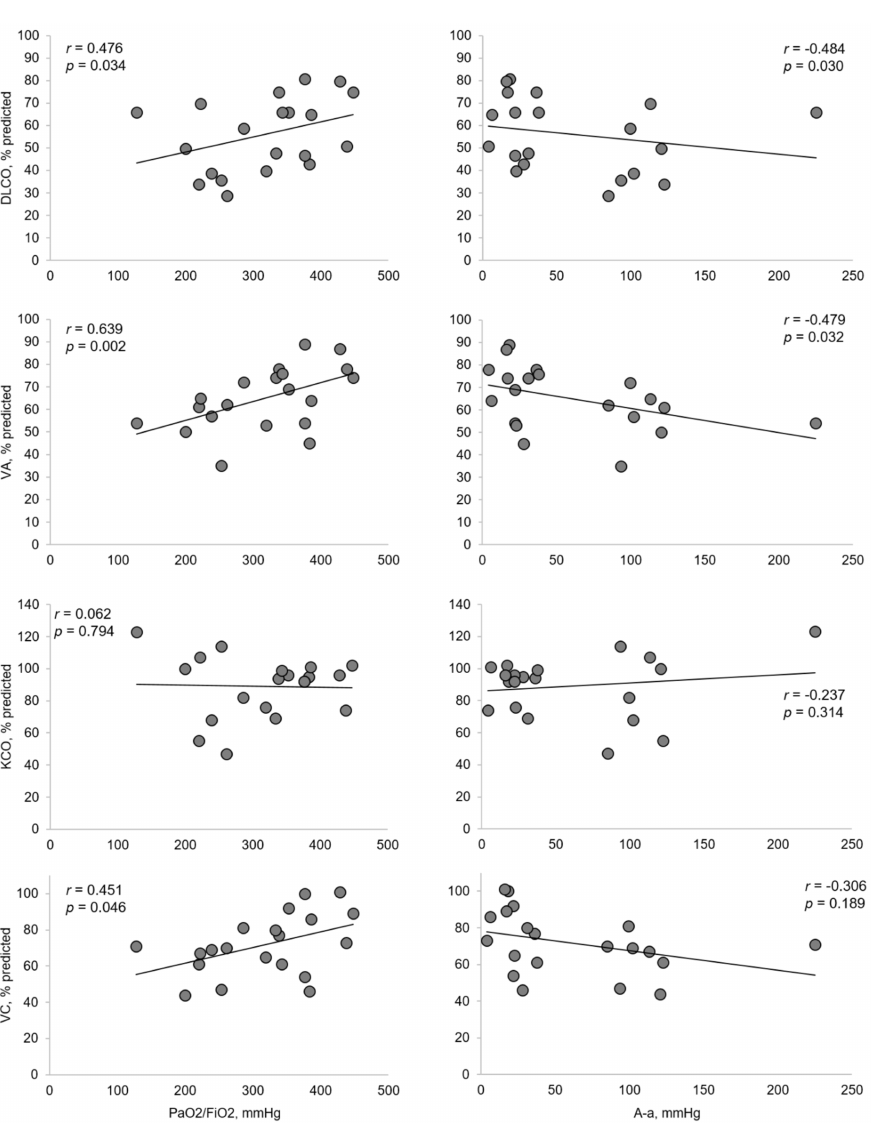
Figure 4. Relationship between PaO 2 /FiO 2 ratio, A-a O 2 gradient and lung diffusion parameters and VC. Correlations with FVC and FEV 1 are not shown due to the strong association with VC (r = 0.859 and r = 0.829, respectively) and between FVC and FEV 1 (r = 0.884). DLco: lung diffusion capacity for carbon monoxide; VA = alveolar volume; KCO = transfer factor for carbon monoxide; VC = vital